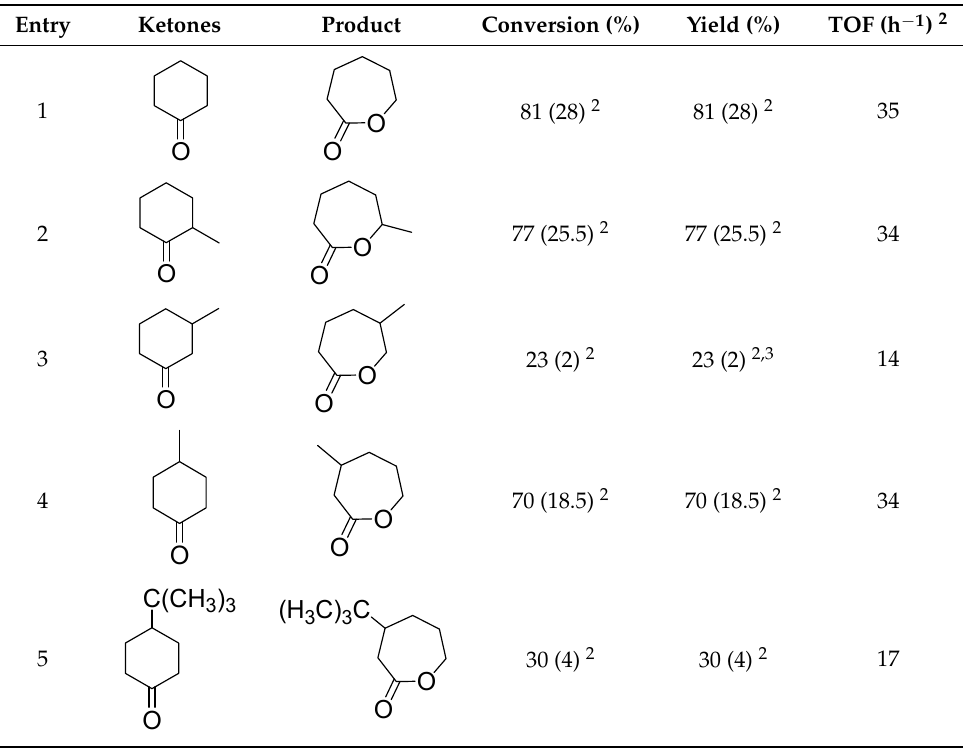
O 2 bubbling, 60 °C, 15 h. 2 Normalized with the stoichiometric results (without catalyst). 3 Two products were formed in a 1:1 ratio.